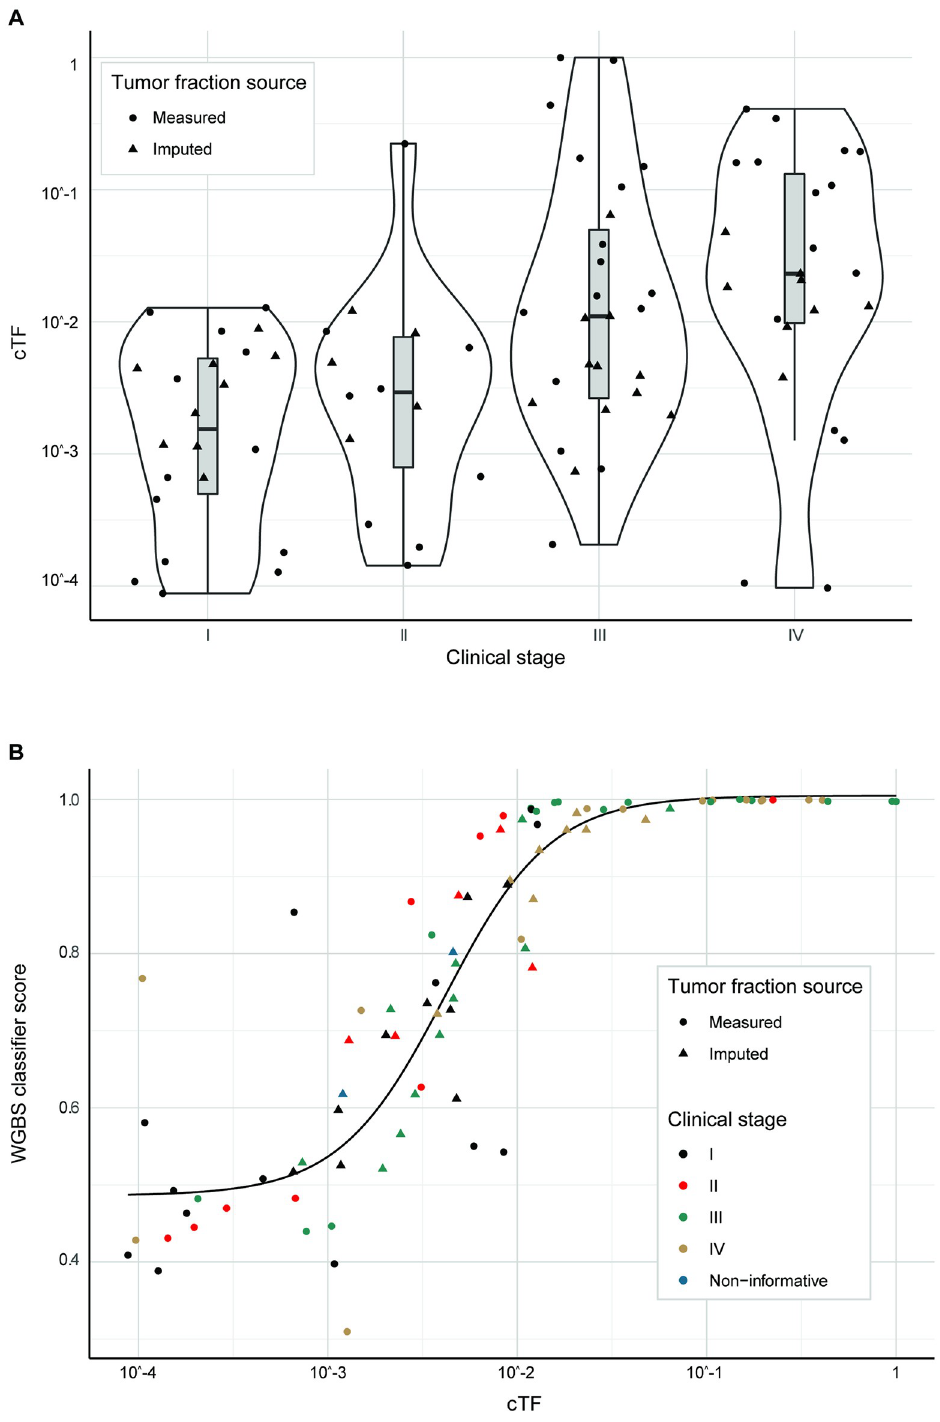
Fig 7. Lung cancer cTF by clinical stage and relation to WGBS classifier score. (A) cTF by clinical stage for lung cancer. (B) WGBS classifier score by cTF for lung cancer. Samples are colored by clinical stage and samples with imputed cTF are shown as triangles. cTF: Circulating Tumor fraction, WGBS: Whole-genome bisulfite sequencing. Non-informative: Confirmed invasive cancer with insufficient clinical information to determine stage.